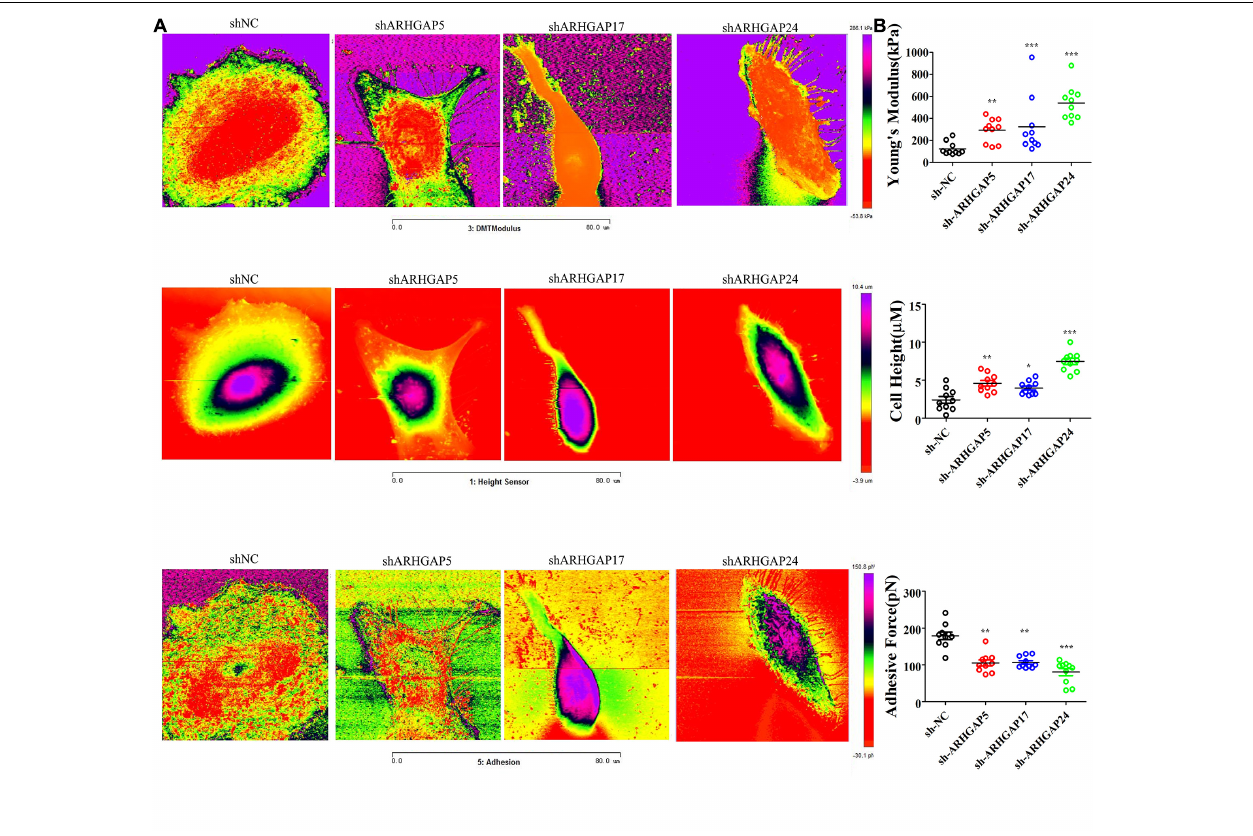
FIGURE 9 | Identification the nanomechanical parameters via knocking down of ARHGAP5, ARHGAP17, and ARHGAP24 in BCa. (A) High-magnification images of the distinctive contrast patterns observed for T24 and knocking down ARHGAP5, ARHGAP17, and ARHGAP24 T24 cells. First-row images correspond to Young’s modulus (YM) maps. Second-row images correspond to cell height. Third-row images correspond to AF maps. (B) All cellular nanomechanical properties were analyzed in GraphPad Prism5 (* p < 0.05; ** p < 0.01; *** p < 0.001; ns, not statistically significant, Wilcoxon signed rank test).